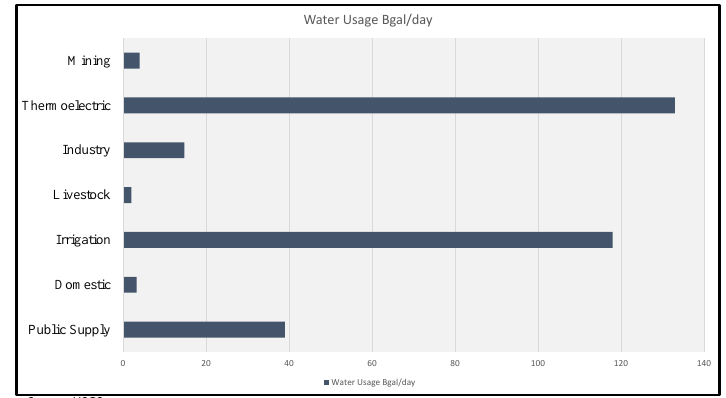
Figure 4. Groundwater and Water Quality Data